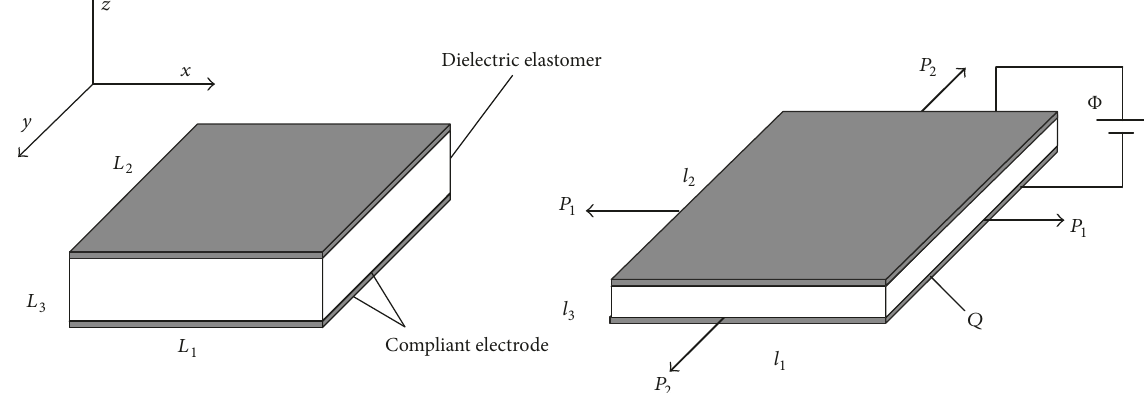
Figure 1: Schematics of a viscoelastic dielectric elastomer subject biaxial force in the plane and voltage through the thickness applied via stretchable